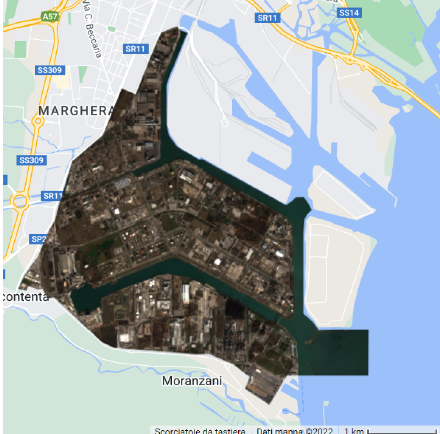
Figure 1. Sentinel-2 multispectral median image (Marghera dock, January-March 2019).